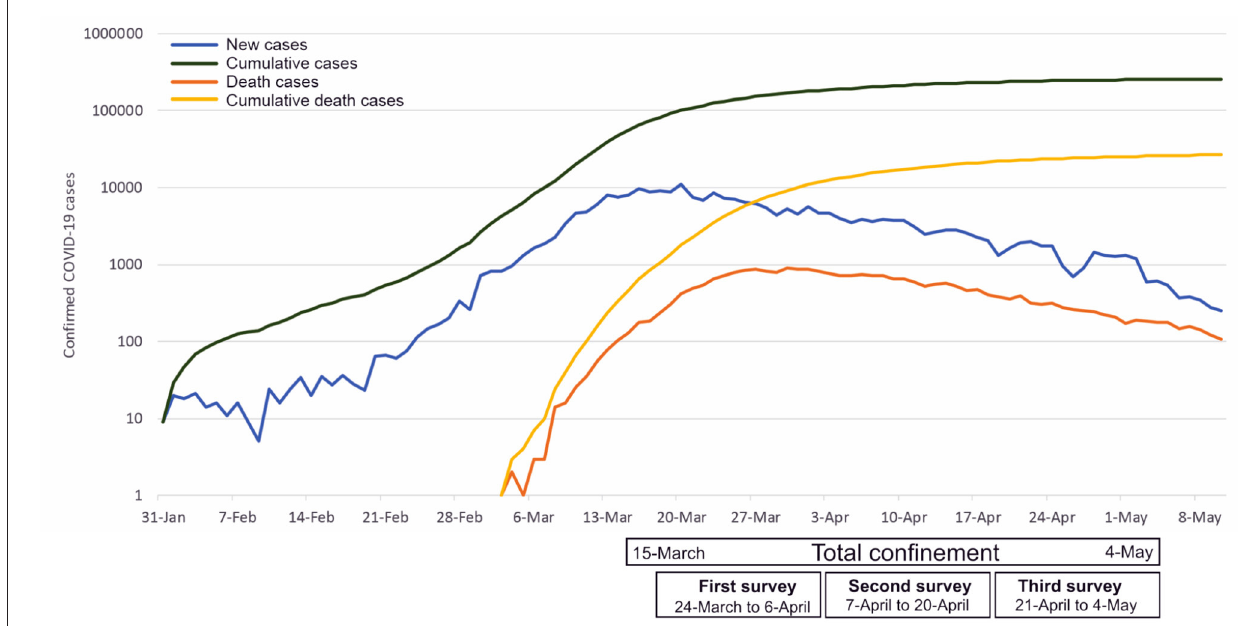
FIGURE 2 | Flow chart indicating the sample size and missing data throughout the collecting data process.